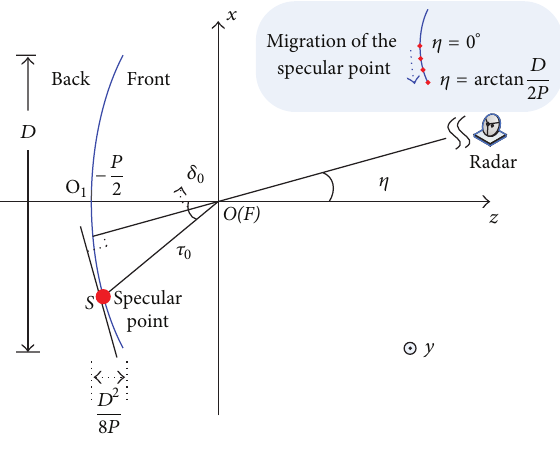
Figure 1: PRA geometry ( 𝑥 - z